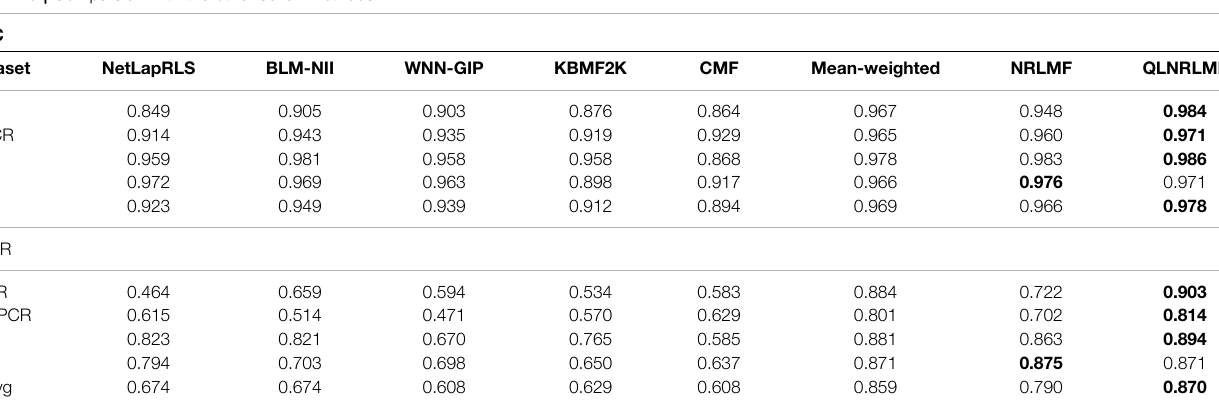
TABLE 5 | Comparsion with the other seven methods.